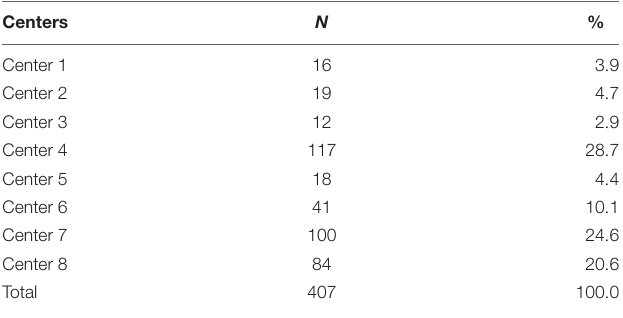
TABLE 1 | Distribution of participants according to the center of early childhood and primary education. Centers N %